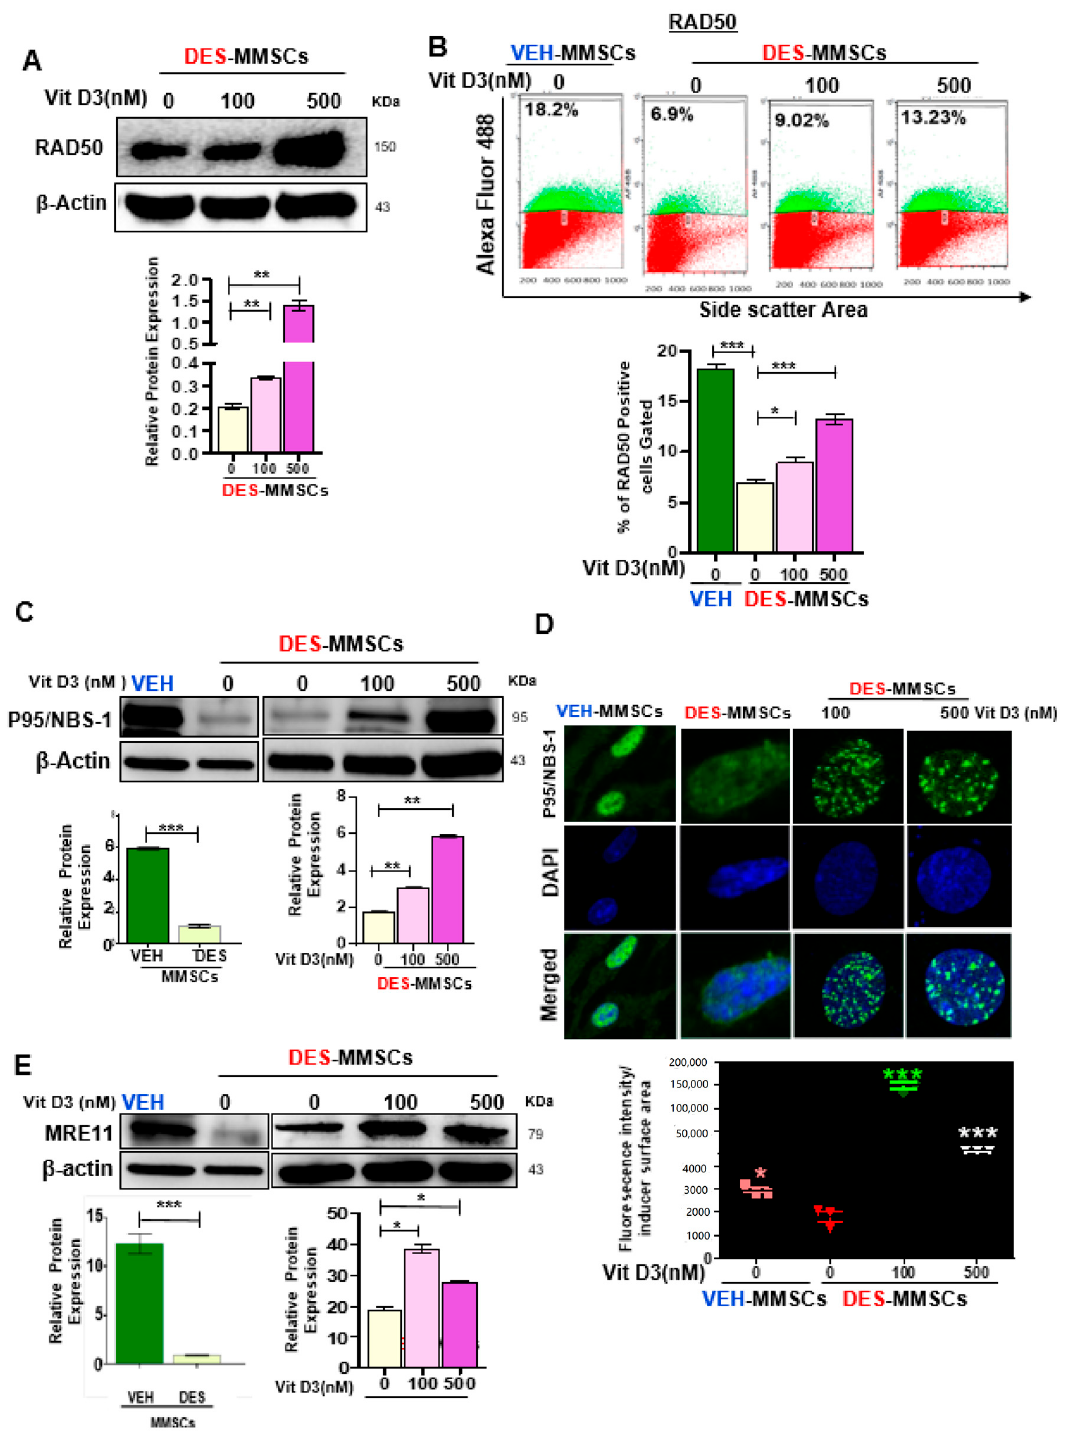
Figure 3. VitD3 increases the expression of DNA repair sensors (RAD50, p95 / NBS-1, and MRE11) in DES-MMSCs. ( A ) The protein levels of RAD50 were determined by Western blot analysis (top panel). A quantitative analysis of Western blot data was performed by Image lab software (bottom